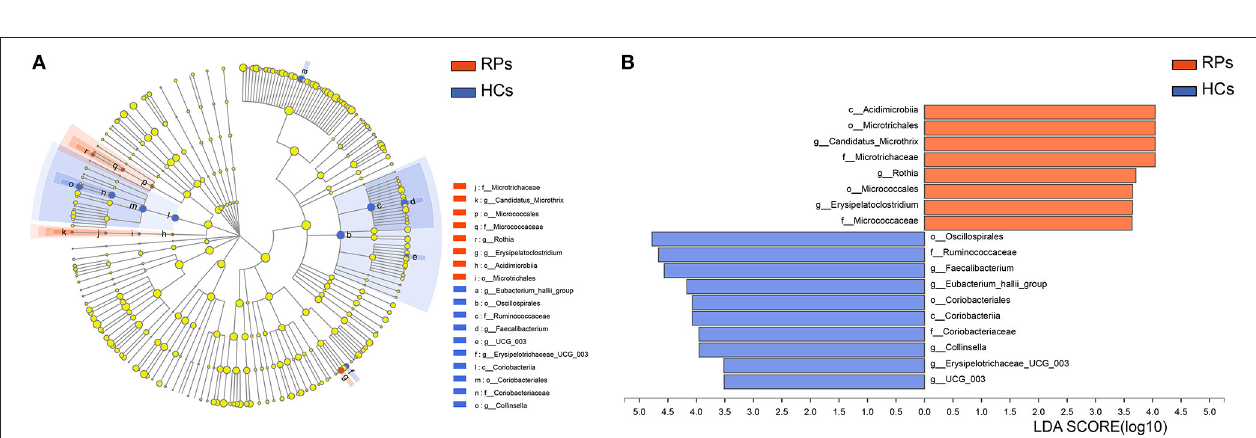
FIGURE 4 | Identifying bacterial differences by the LEfSe. (A) Taxonomic cladogram shows the taxa that were considered statistically significant between two groups from the Phylum to the Genus level. (B) the LDA score of differentially enriched taxa in healthy controls and COVID-19 group (LDA threshold value >